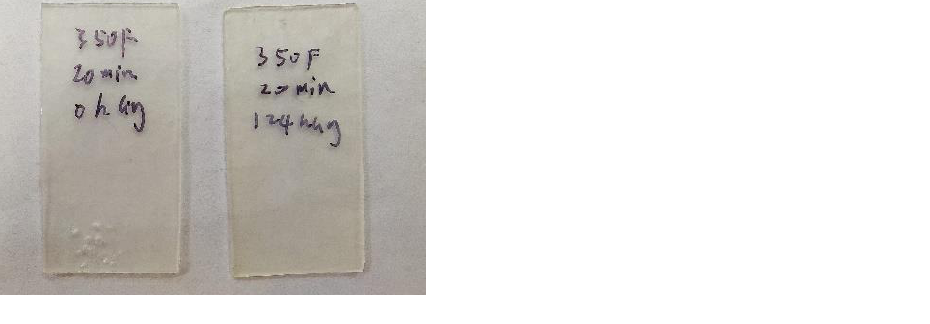
Figure 8. Samples for 0 kGy (left) and 124 kGy (right, 2014/2015 irradiated) resins tested at 177 °C for 20 min.